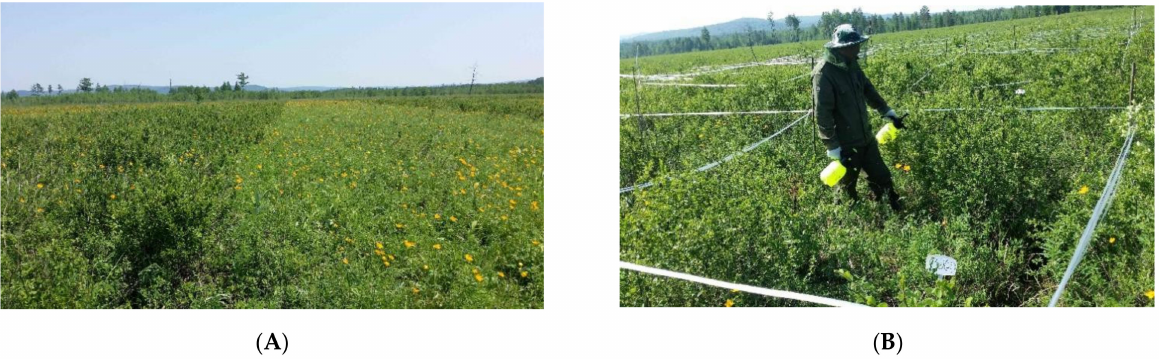
Figure 3. A bog blueberry field site ( A ) in Amul, Mohe (MH) and one of the sampled clones ( B ). Photos were taken by Dr. Dianwen Wei.